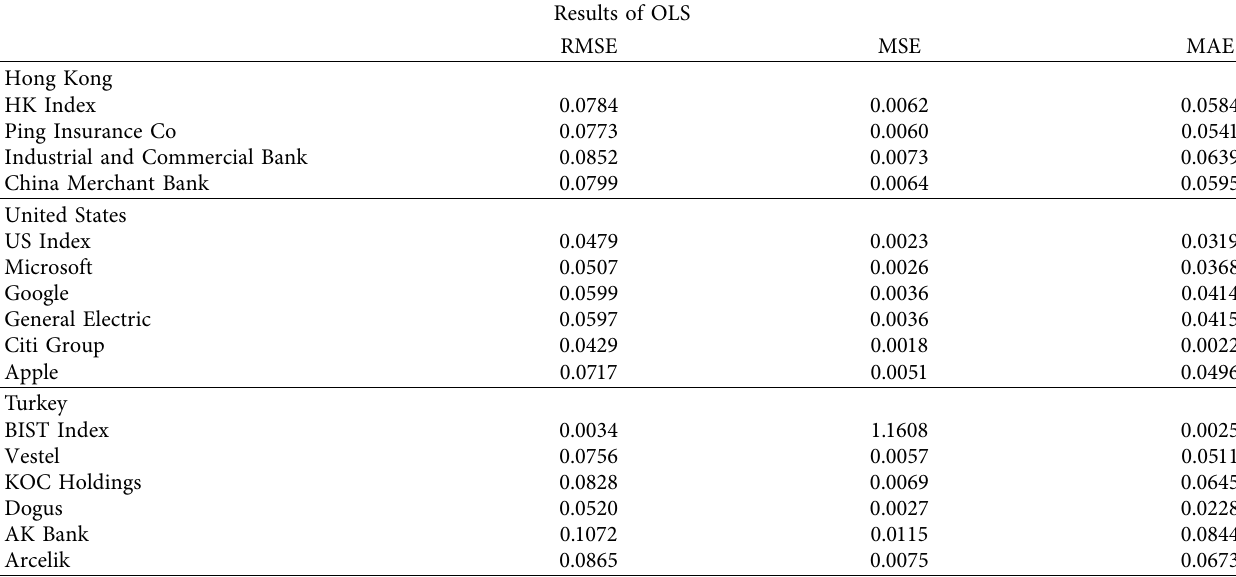
Table 15: Results of OLS method for all companies of Hong Kong, US, and Turkey with